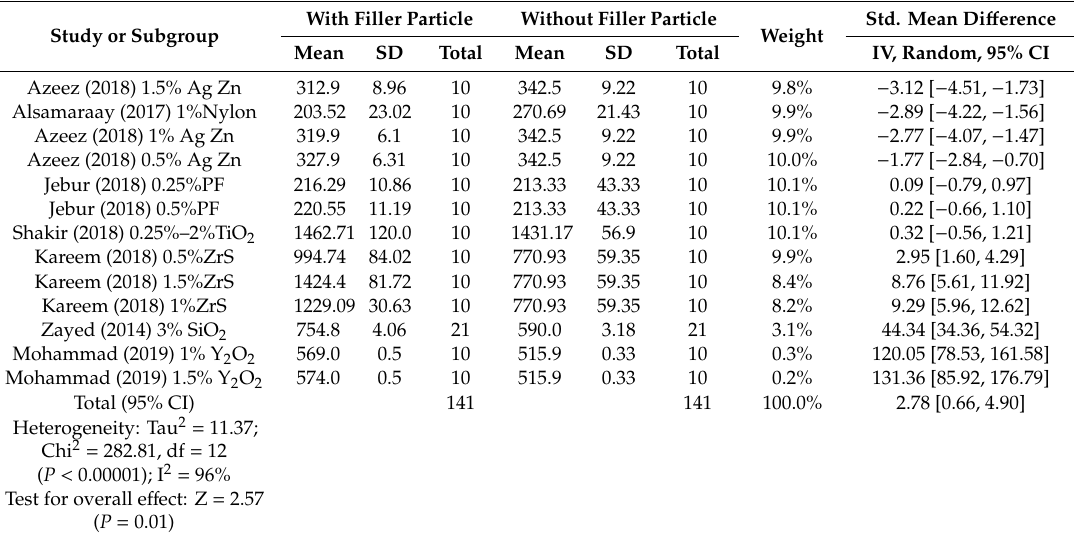
Table 9. Summary findings and forest plot of elongation at break (%) outcomes in case-control studies incorporating filler particles with MFPSE.